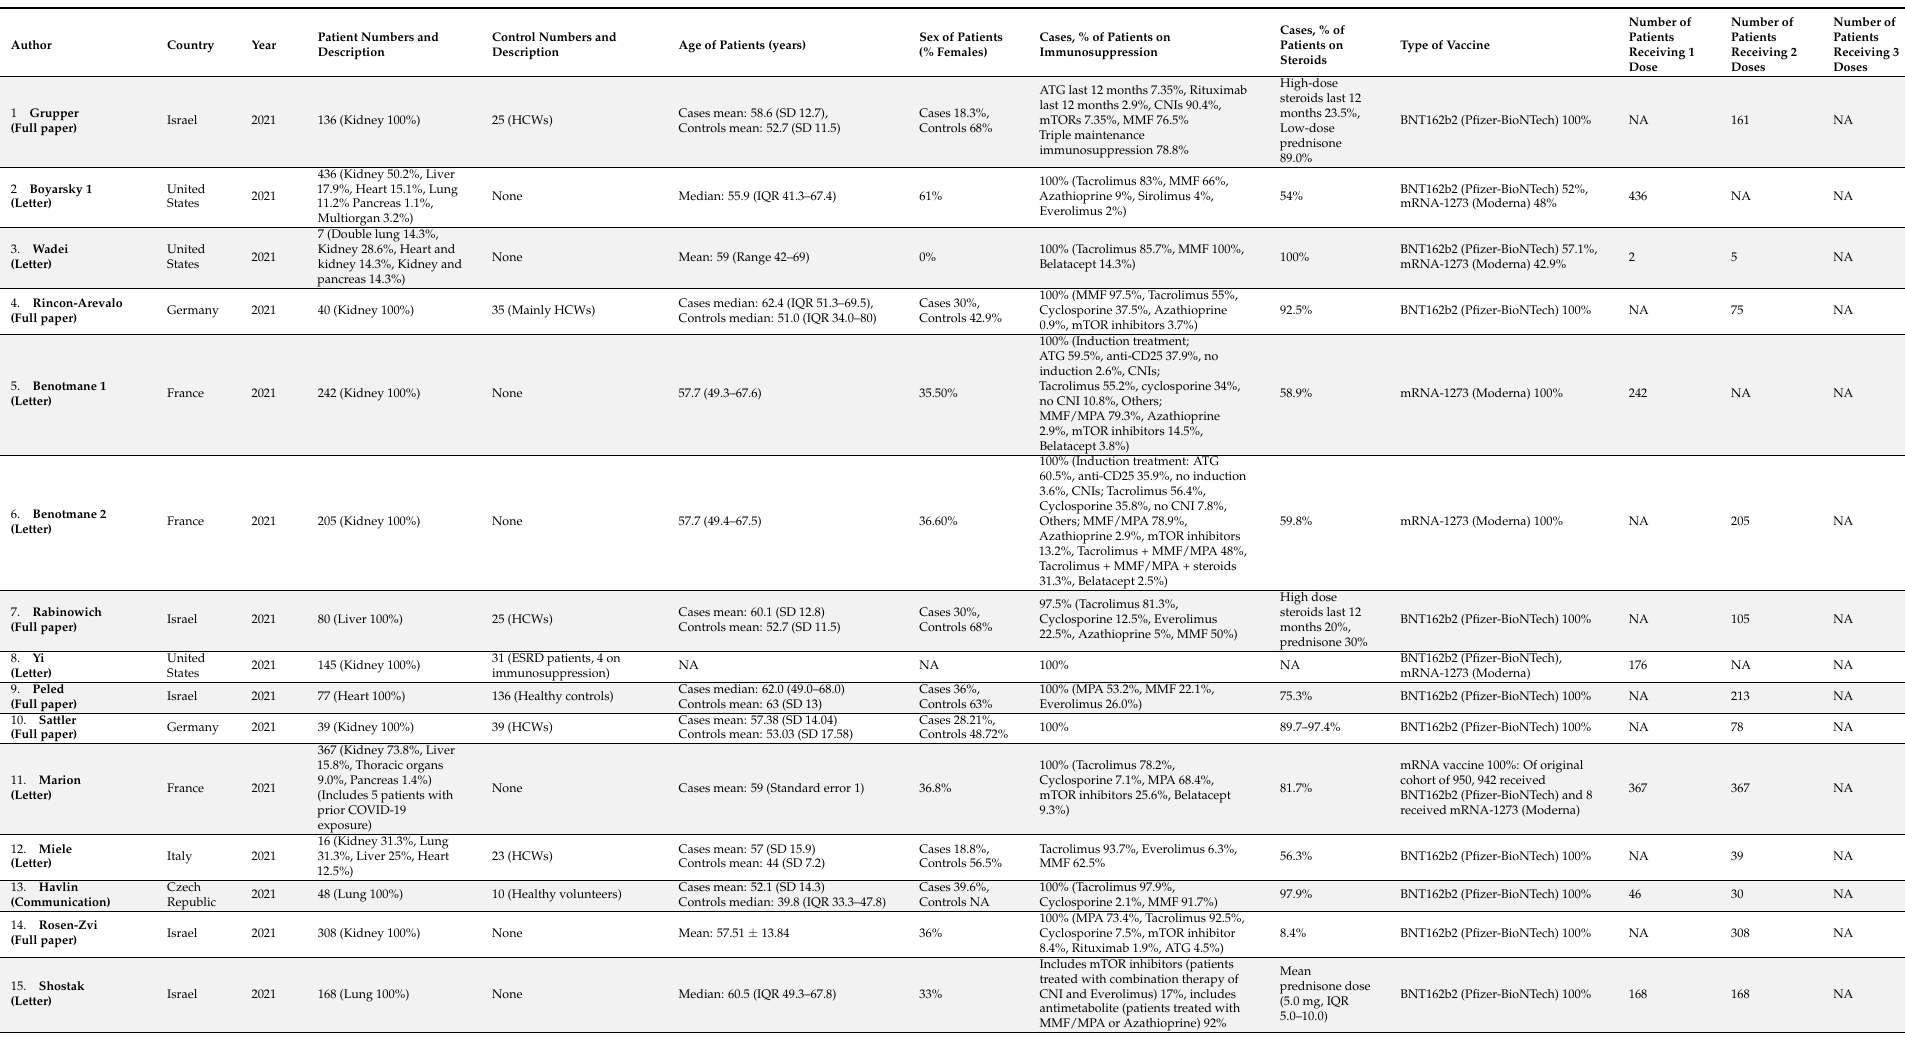
Table 1. Characteristics and outcomes of the included